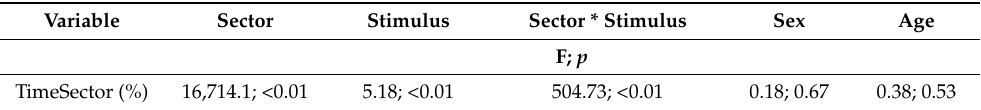
Table 2. Statistical significance of Sector, Stimulus and the interaction of Sector and Stimulus (Sector * Stimulus) for TimeSector (the % of total time spent in each